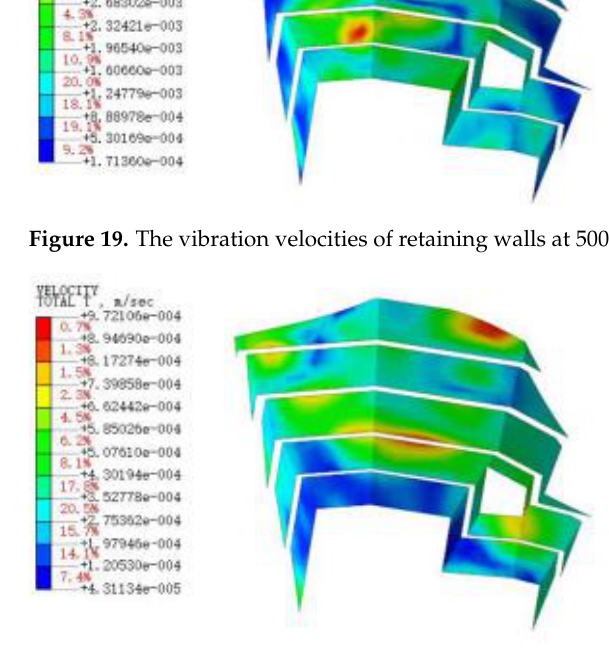
15 of 26 Figure 16. The vibration velocities of retaining walls at 100 ms. Figure 17. The vibration velocities of retaining walls at 200 ms.